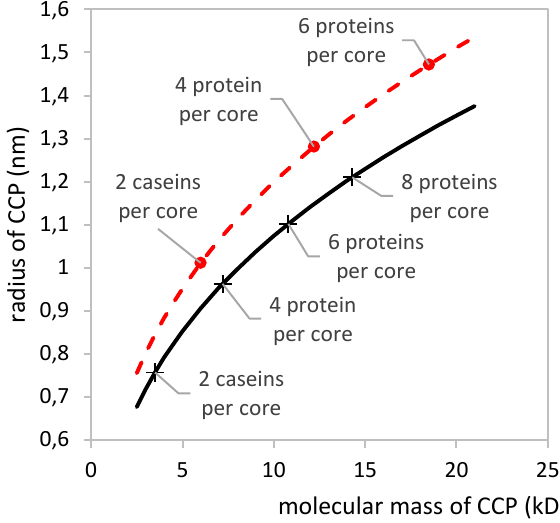
Figure 2: Radius of a CCP core calculated from its hypothetical molecular mass, marked points show stoichiometry assuming 1g of calcium to 35g of protein (molecular mass 25 kDa). Dashed red curve demonstrates a calculation based on a brushite core with 23% calcium by mass (CaHPO black line demonstrates hydroxyapatite core Ca density of 3200 kg/m 3